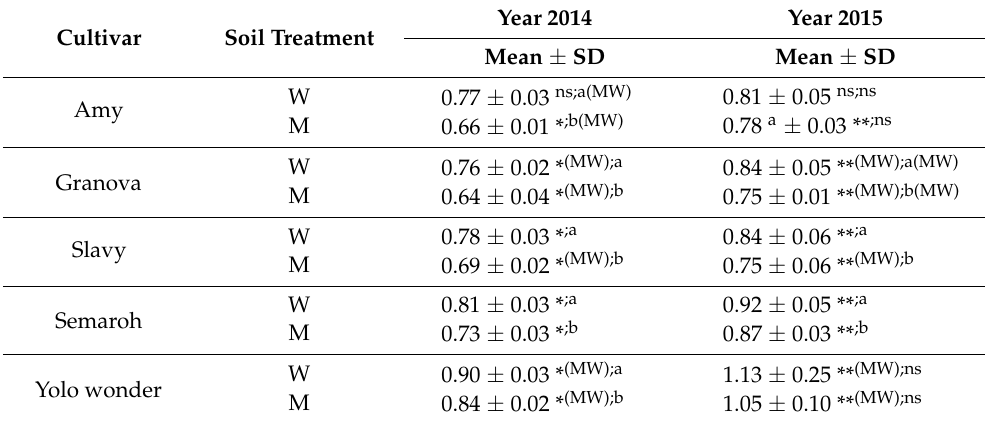
Table 6. Total polyphenol content (g GAE · kg − 1 fresh